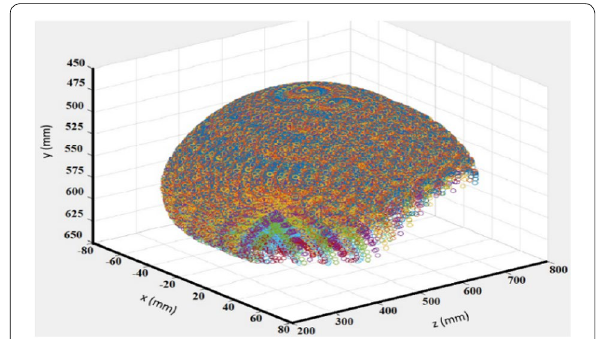
Figure 11 Singularity-free